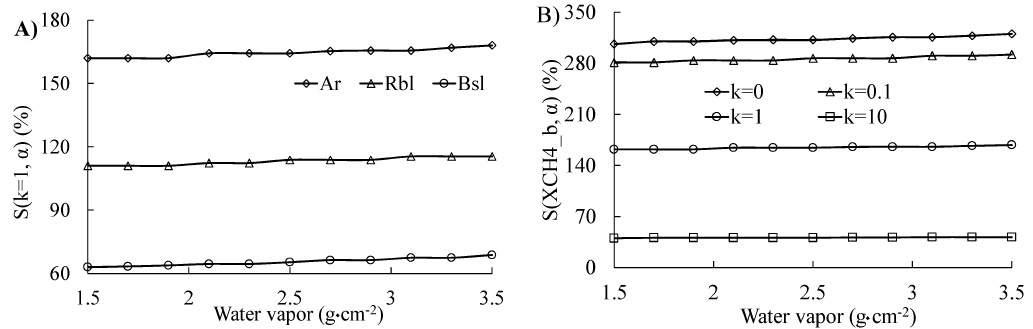
Figure A5. S (XCH 4_b , α ) resulted from a combination of an absolute underestimation of 0.02 in (cid:36) s and a relative overestimation of 9% in column water vapor for ( A ) three pixels Asphalt road (Ar), Brown sandy loam (Bsl), and Reddish brown sandy loam (Rbl) with the XCH 4 plume case of k = 1, and ( B ) the pixel Ar with XCH 4 plume cases of k = 0, 0.1, 1,